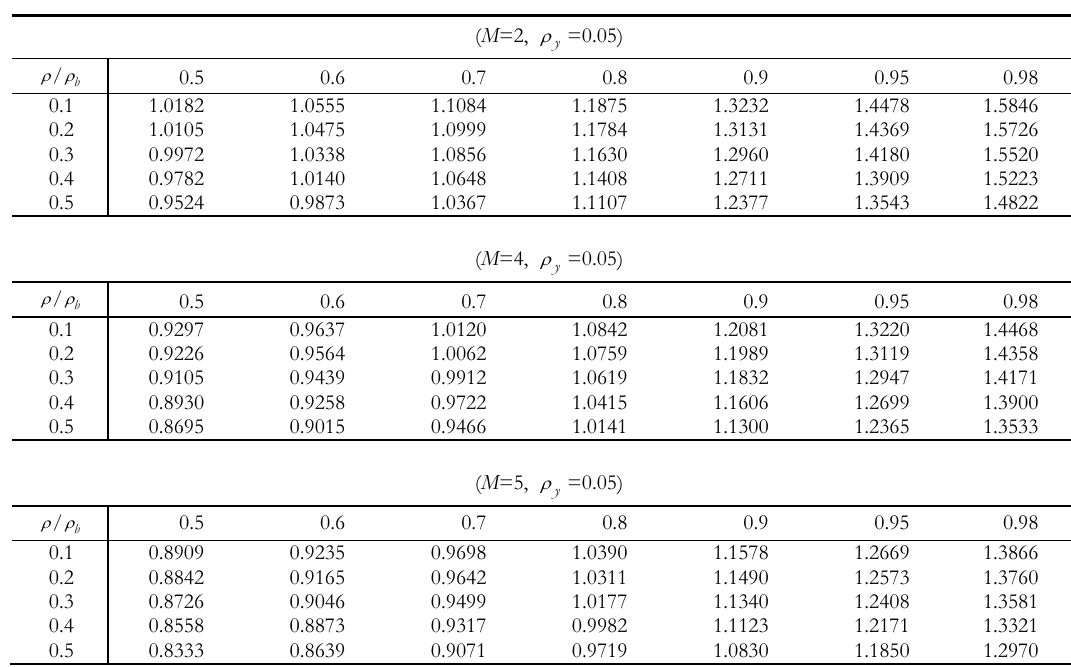
Relative efficiency of cluster sampling over simple random sampling